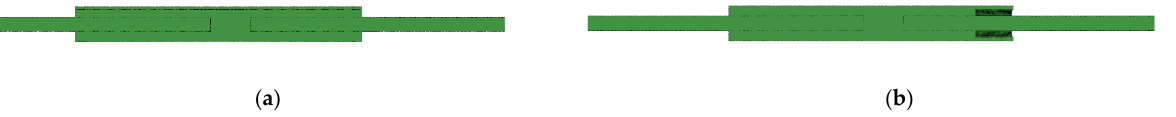
Figure 8. Grouting defect grid schematics. ( a ) Without defects. ( b ) With 25% defects at the end.